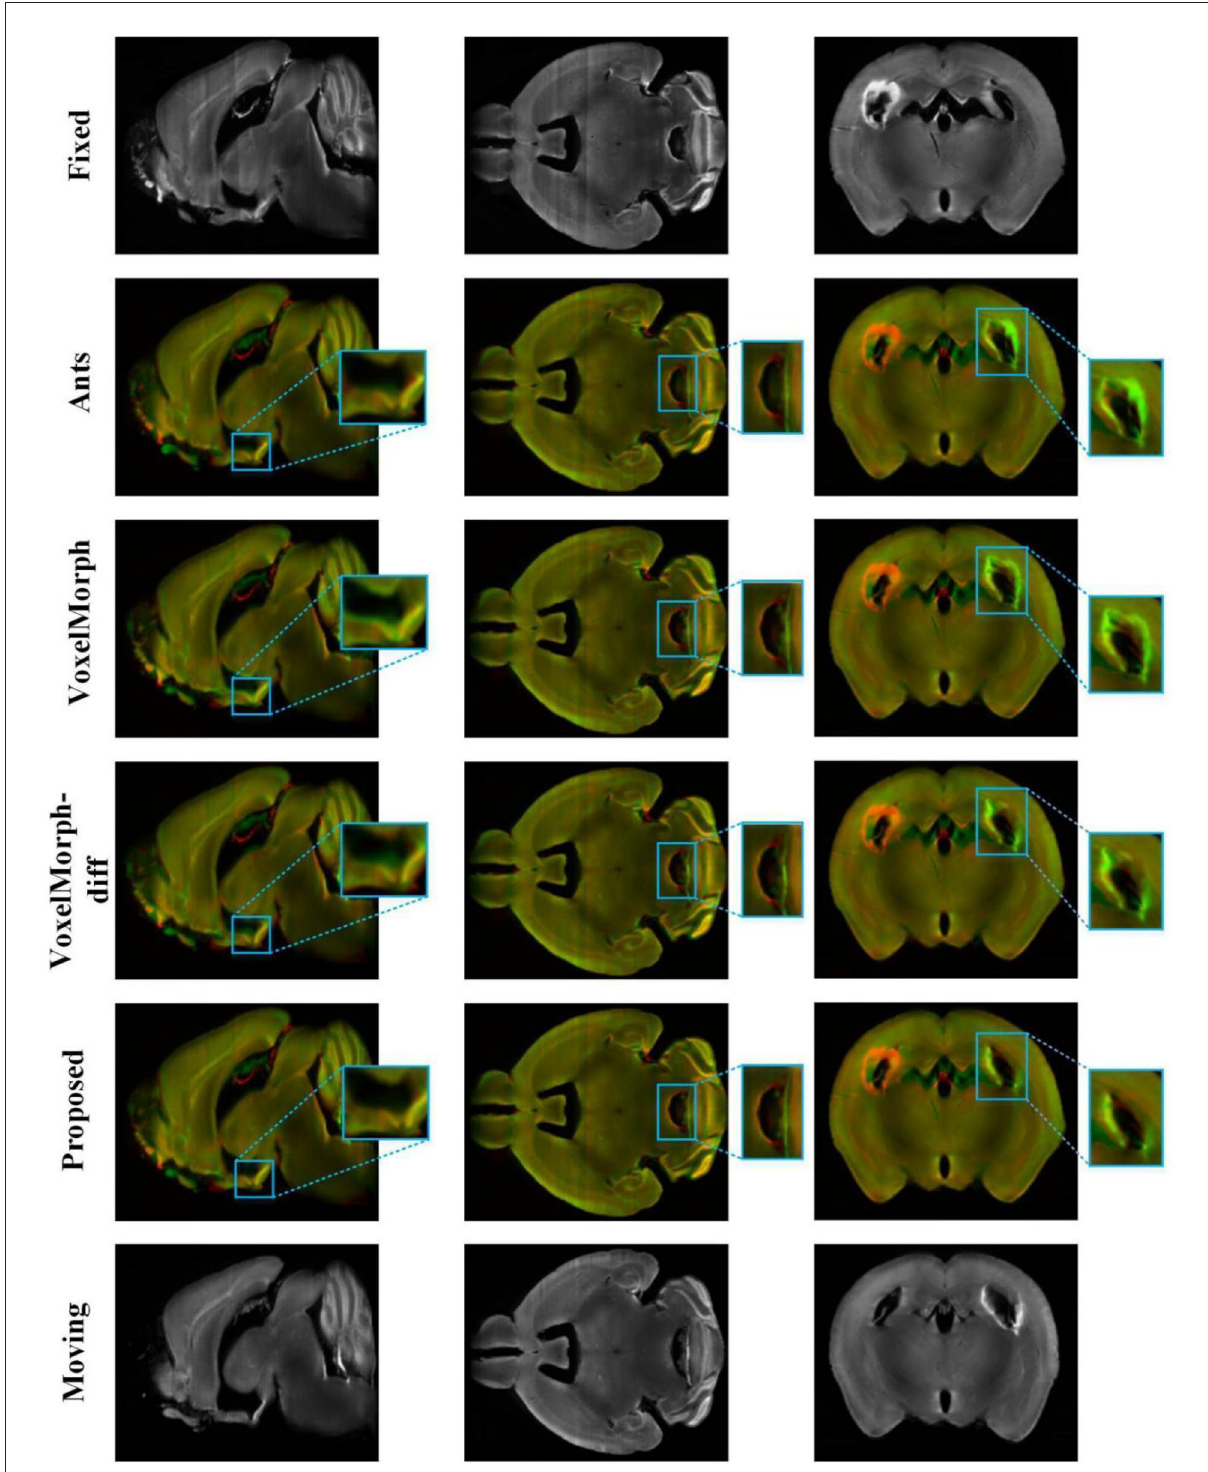
FIGURE5 The registration results of different methods on the mouse brain test set. The 2–5 rows show 2D slices of multi-channel color blend between the registered results and the fixed image by different methods [ANTs (SyN), VoxelMorph, VoxelMorph-diff, and our proposed method] on the mouse brain test set. The red channel is the fixed image and the green channel is the different registration results. The blue box is the part we want to